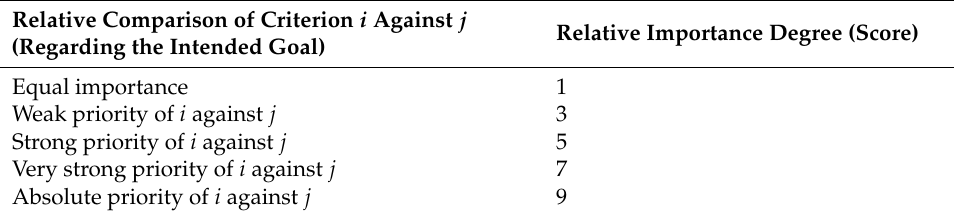
Table 2. Comparison criteria according to the relative importance